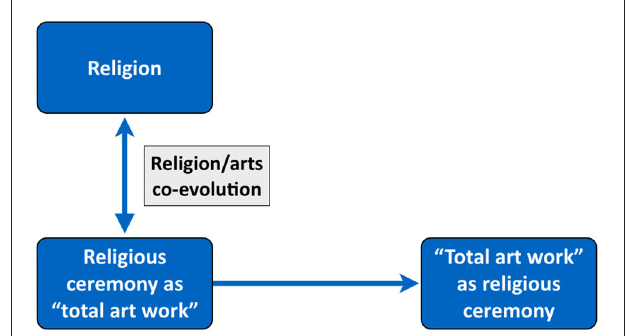
FIGURE 4 | The relationship between religion, the arts, and the Gesamtkunstwerk . The hypothesis of religion/arts co-evolution (RACE) argues that the emergences of religious practice and the arts are intimately interwoven during human history. The common point of focus is the ceremonial ritual, which is proposed to be a collection of arts behaviors and objects, making it essentially a “total work of art.” The aesthetic Gesamtkunstwerk later evolved in large-scale cultures in the context of artistic practice. It has a strong spiritual and ceremonial dimension to it, reminiscent of a religious